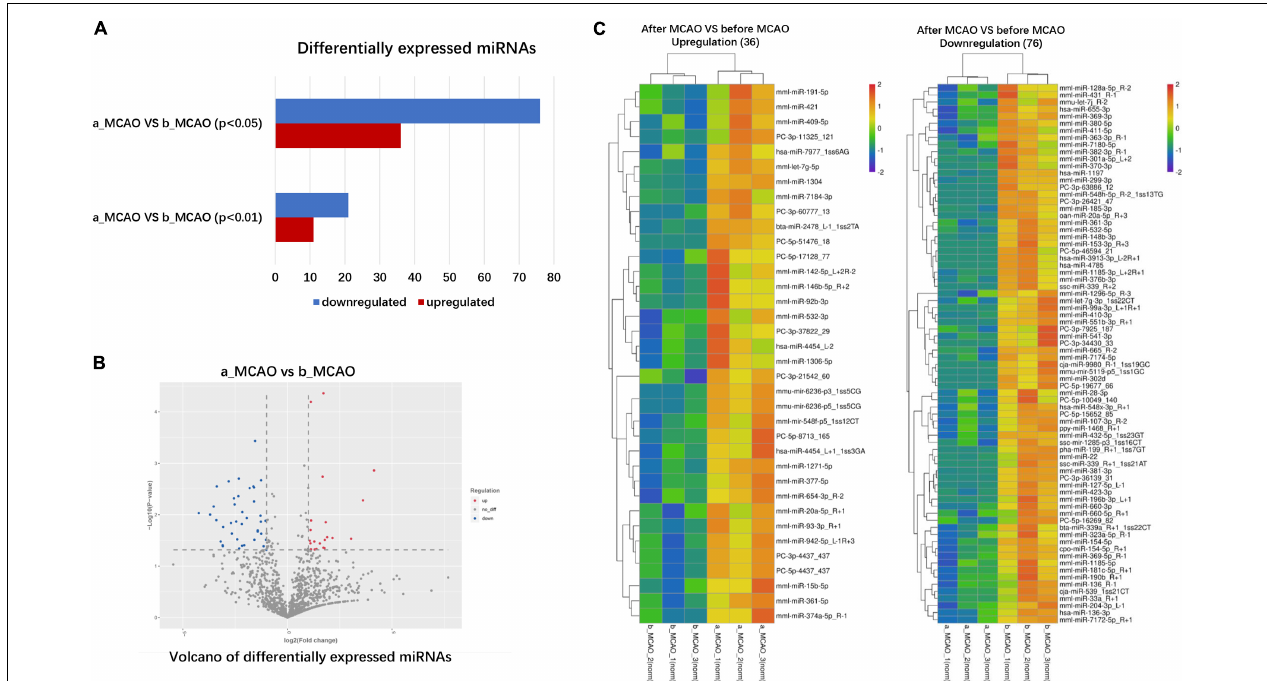
FIGURE 2 | Differentially expressed plasma miRNAs of rhesus monkey before and after cerebral ischemia. (A) The blue represents down–down miRNA, and the number represents up–down miRNA. (B) Volcano plot analysis showing differentially expressed miRNAs, using log 2 (fold change) as abscissa and –log 10 ( P -value) as ordinate. The red and blue dot represent the up-regulated or down-regulated differential expression genes, and the gray dot represents the non-significant differential expression genes. (C) Hierarchical clustering heatmap analysis of upregulated and downregulated miRNAs detected in plasma of rhesus monkey before and after cerebral ischemia. Red indicates high expression genes and blue indicates low expression genes. b_MCAO_1-3, before ischemia; a_MCAO_1-3, after ischemia. N = 3.